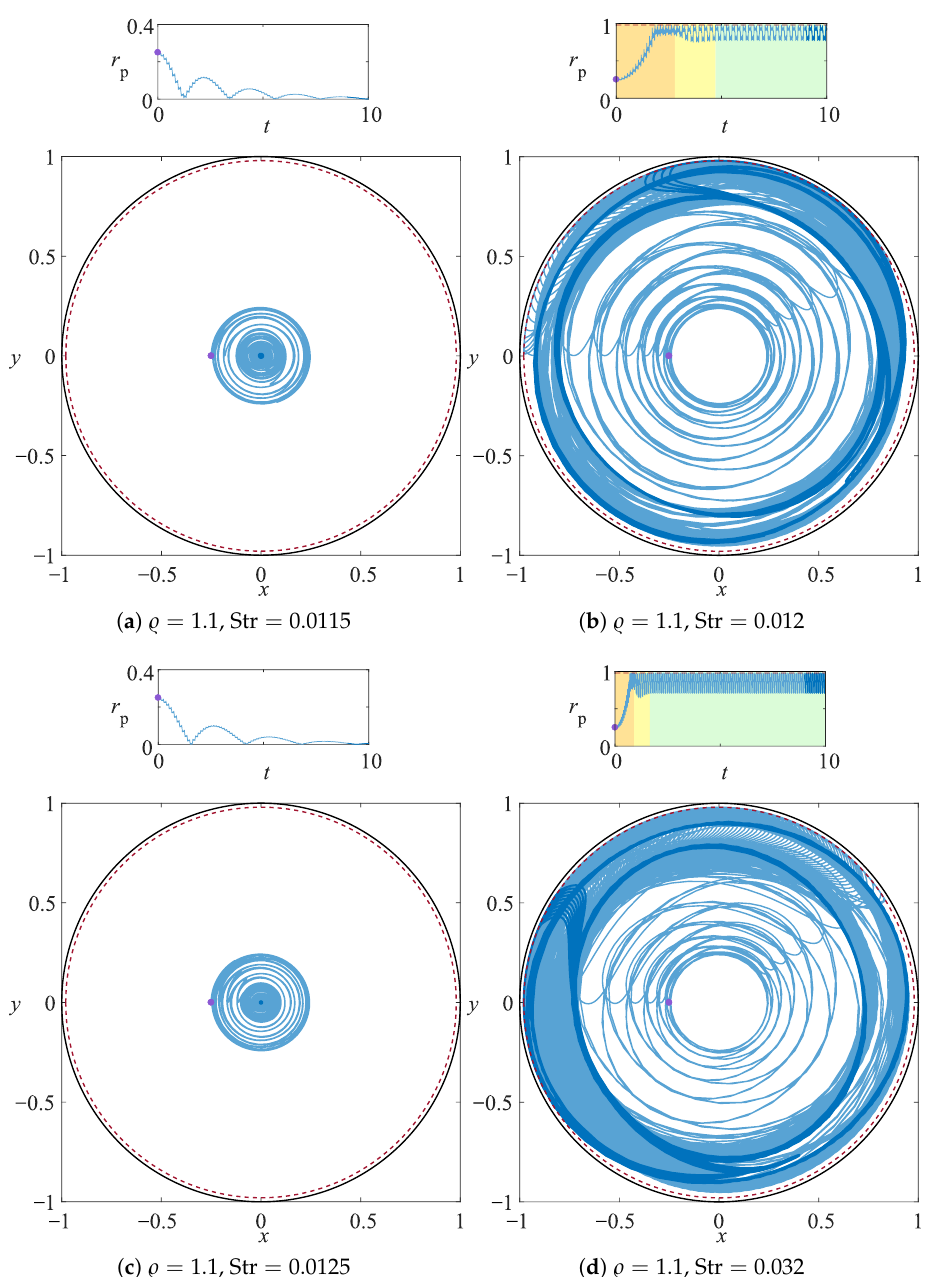
Figure 5. Radial coordinate r p of a particle trajectory for (cid:36) = 1.1, St = 1 and Str = 0.0115, 0.012, 0.0125, and 0.032. The trajectories are integrated for t = 10 and they are denoted by the light-blue line. The darkblue solid line shows the last 10% of the particle orbit and the purple dot its initial position. The red dashed line identifies the sliding surface of the particle–surface interaction (PSI) model, which surface is at distance ∆ = a from the driving boundary. The orange background denotes the particle attraction phase to a quasi-steady unstable attractor, the yellow background highlights the transition phase and the green background shows the orbit attraction to the stable traveling